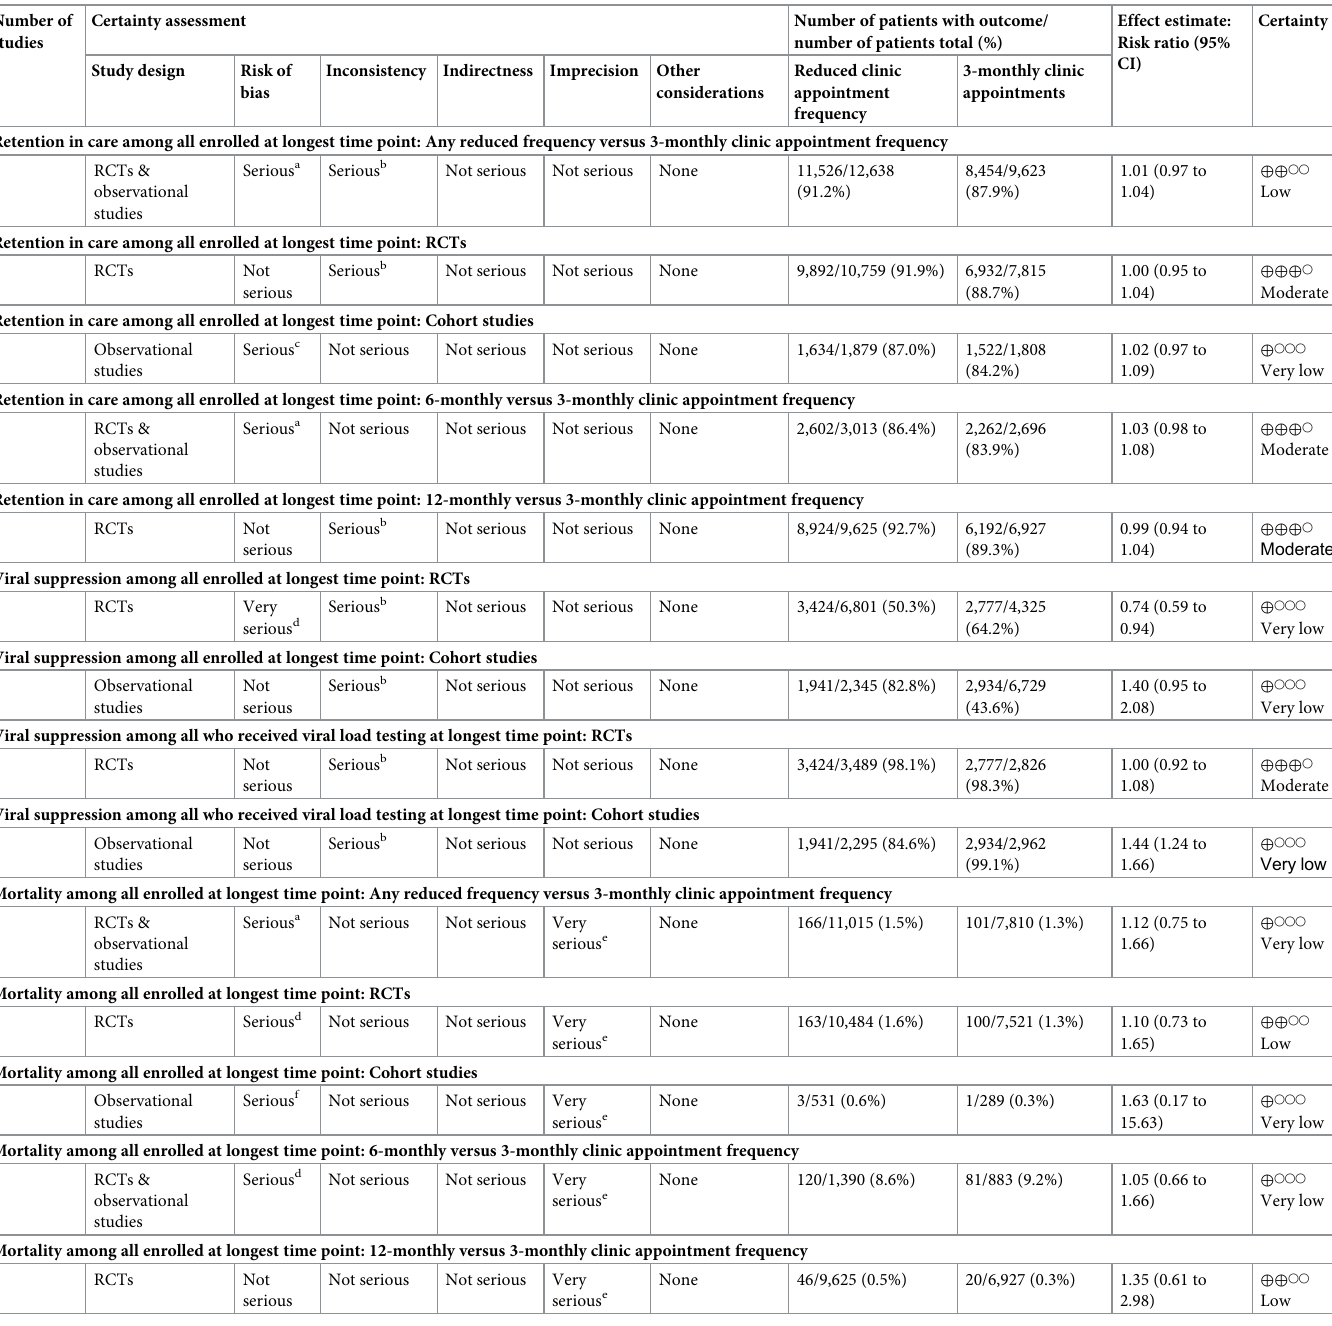
Table 6. Review evidence certainty assessment (GRADE): Reduced clinical appointment frequency (6- or 12-monthly) versus 3-monthly clinical